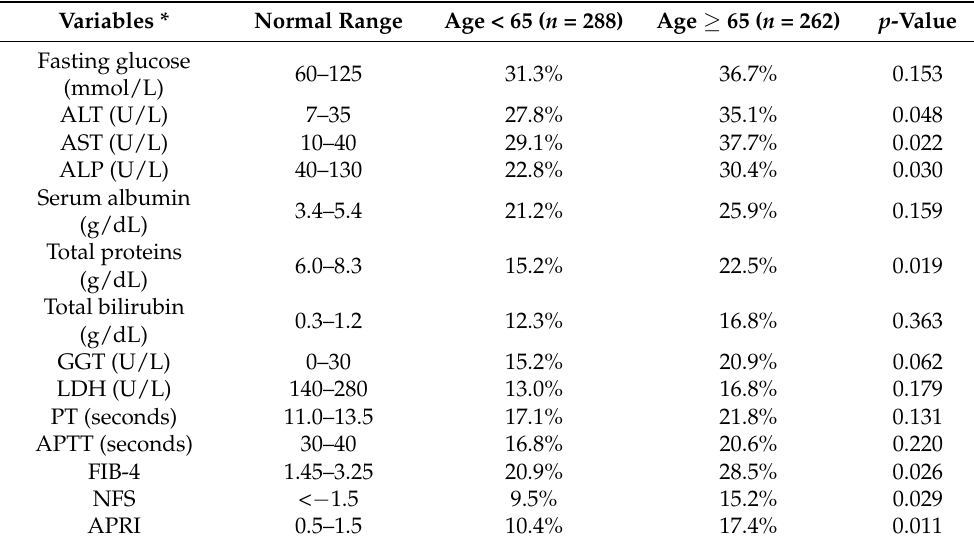
Table 4. Comparison of liver studies at discharge between cases and controls.